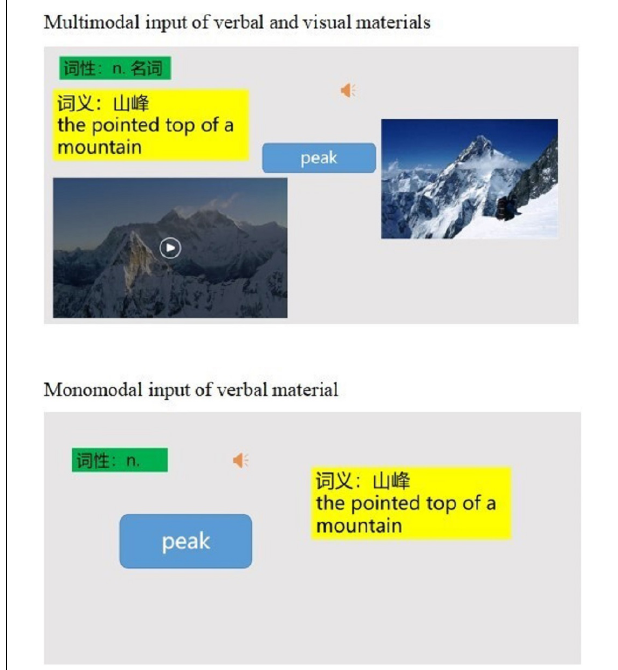
FIGURE 1 | The two experimental treatments in this study illustrated with the target word peak.